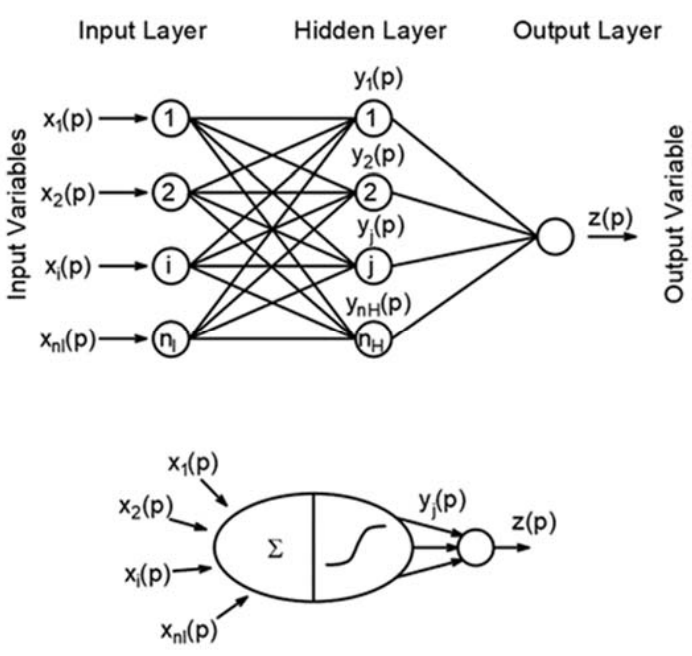
Figure 8. Arrangement of neurons in an artificial neural (forward) network.